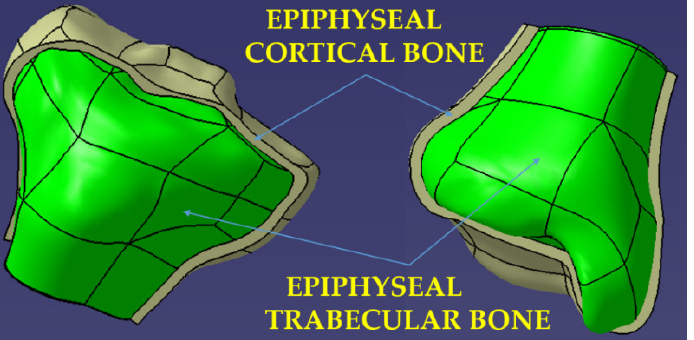
Figure 2. Three-dimensional model of the distal and proximal epiphysis—real structure of the